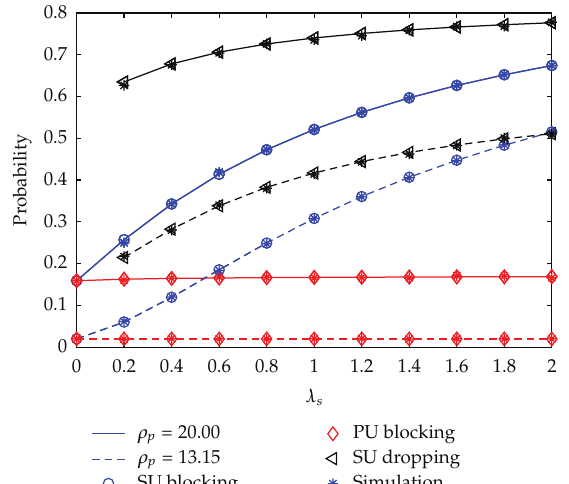
Figure 3: PU and SU blocking probabilities and SU dropping probability versus λ s in SUC mode. The system parameters are N (cid:8) 20, μ p (cid:8) μ s and λ p (cid:8)